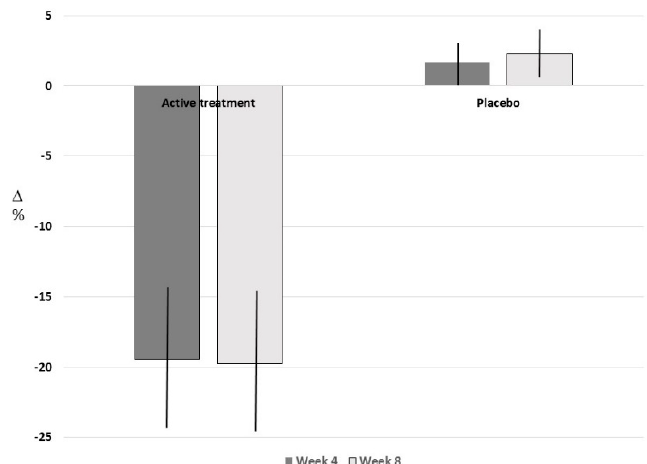
Figure 3. Plasma LDL-Cholesterol level percentage change from the baseline to 4 and 8 weeks in subjects treated with the tested combined nutraceutical or placebo.